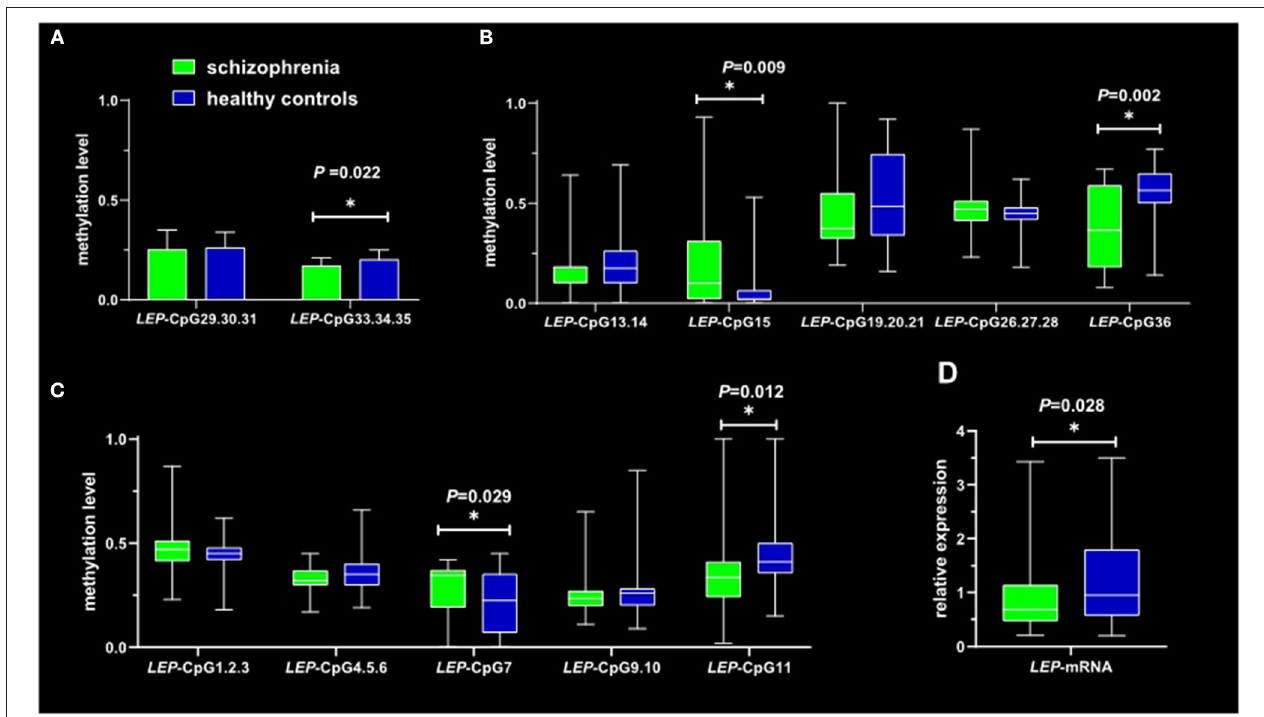
FIGURE 2 | Between-group comparison of Leptin CpG site methylation and mRNA expression. The two-sample t -test was used to assess the differences in leptin CpG sites methylation (A) in the promoter resign between patients and healthy groups. A Mann-Whitney U -test (B–D) was used to assess the differences in leptin CpG sites methylation which were consisted with abnormal distribution. * P <